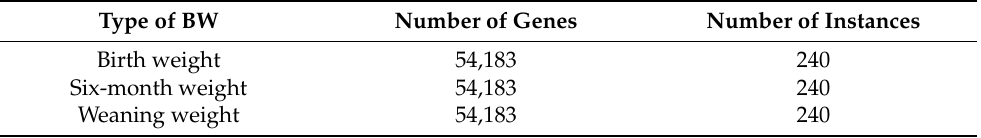
Table 1. The characteristics of a dataset for three measures of BWs from Hu sheep. Type of BW Number of Genes Number of Instances Birth weight 54,183 240 Six-month weight 54,183 240 Weaning weight 54,183 240